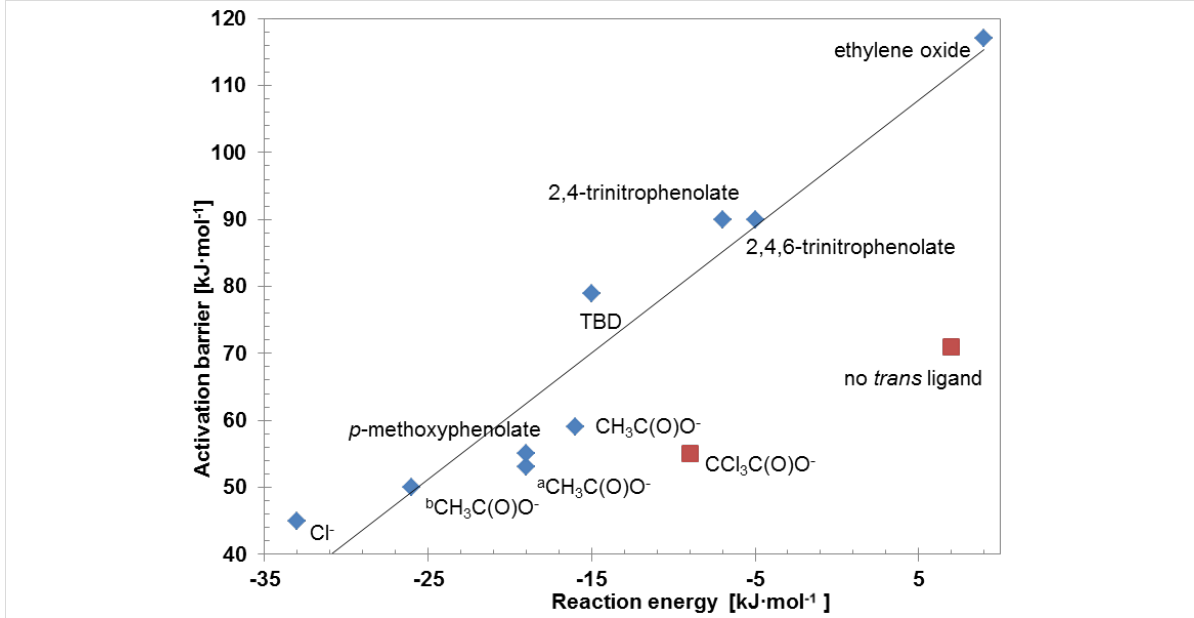
Figure 5: Energy relationship between the activation barrier and the reaction energy of the CO 2 incorporation reaction. Plotted are the results for different nucleophiles L, attached to the Co III –salen base structure as depicted in Figure 2; a salen ligand 1a : = -C 4 H 8 -, R 3–6 = H; b salen ligand 1b : = -C 4 H 8 -, R 3–6 = t -Bu. The energies calculated for those ligands depicted with a red square do not follow the BEP relationship (for details, see text). The line represents the equation E a = (1.9 ± 0.2)· Δ E + (99 ± 4) [kJ·mol − 1